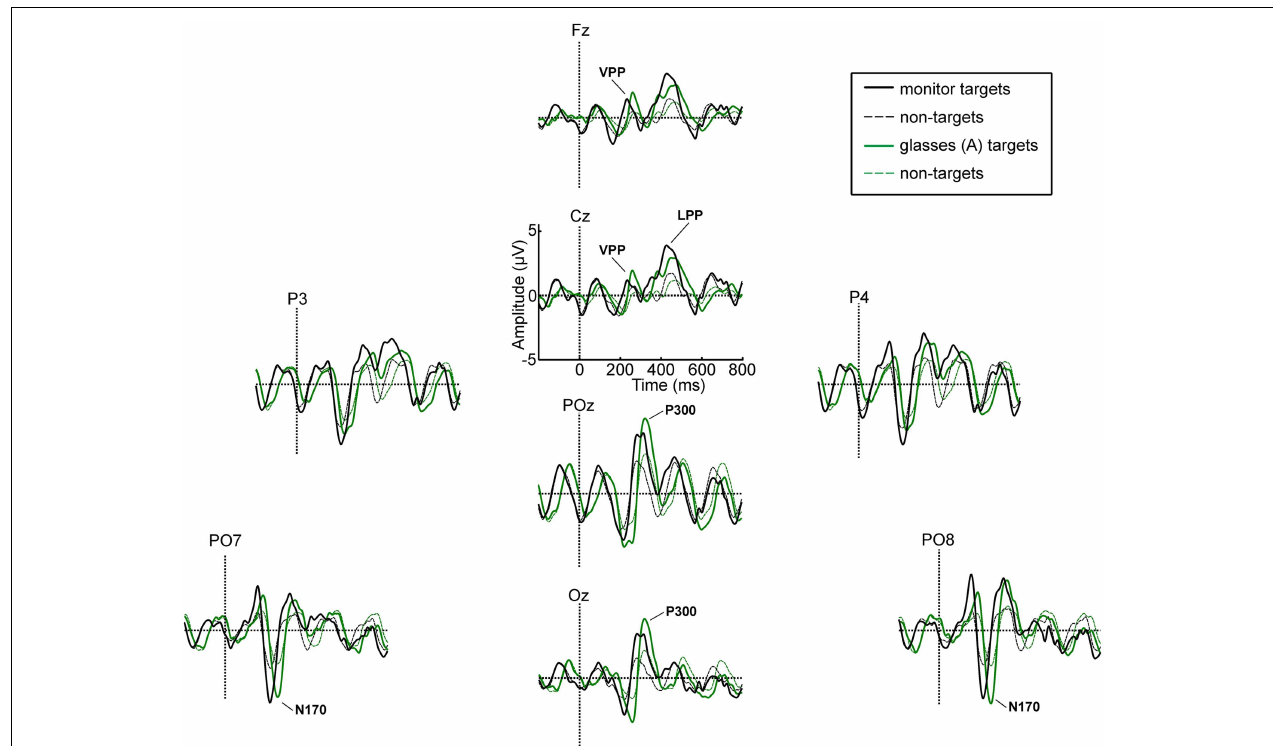
FIGURE 5 | Grand average ERP waveforms for targets and non-targets for the monitor and glasses A condition.